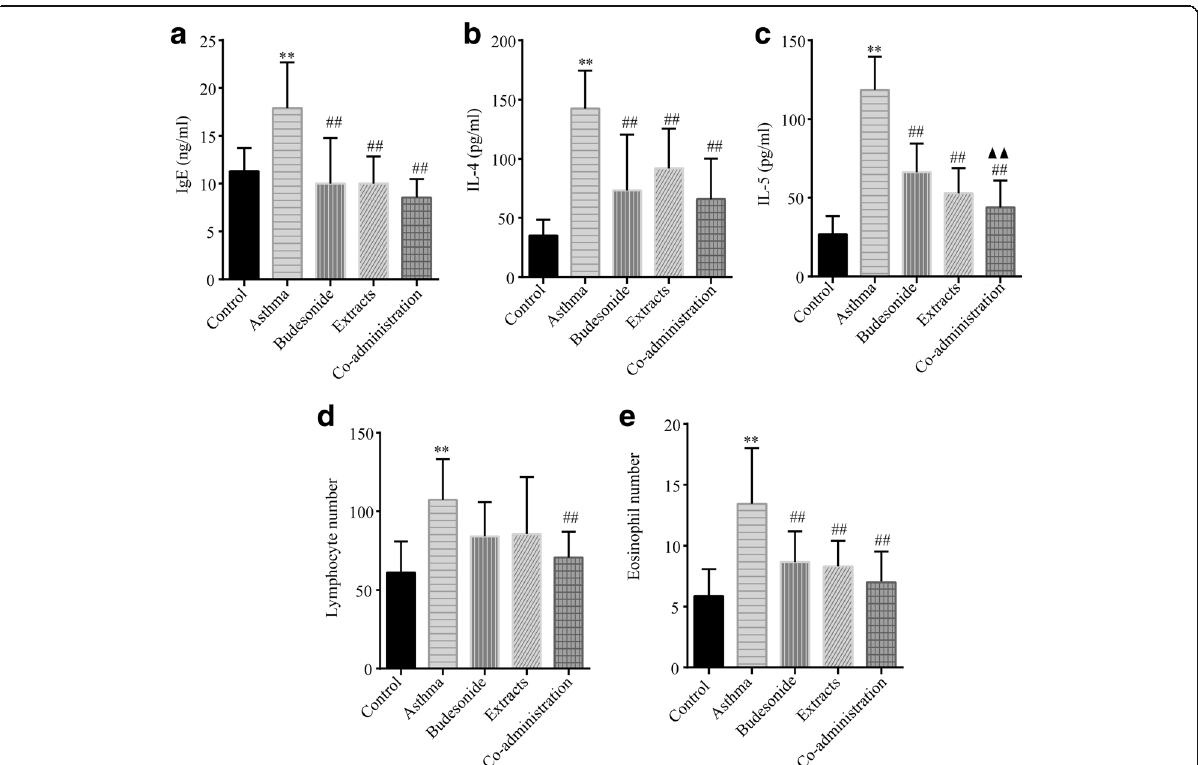
Fig. 3 Effects of budesonide and the herbal extracts on airway inflammation. The serum levels of IL-4 ( a ), IL-5 ( b ) and IgE ( c ) were assayed by ELISA. Lymphocytes ( d ) and eosinophils ( e ) were count on BLAF cytospin by Wright-Giemsa staining. The serum levels of IL-4, IL-5 and IgE and the number of lymphocytes and eosinophils in the OVA-induced asthmatic rats were significantly increased compared with those in the normal control group. Mean ± SD, n = 9. ** P < 0.01 compared to normal control group; ## P < 0.01 compared to asthma model group; ▲▲ P < 0.01 compared to budesonide